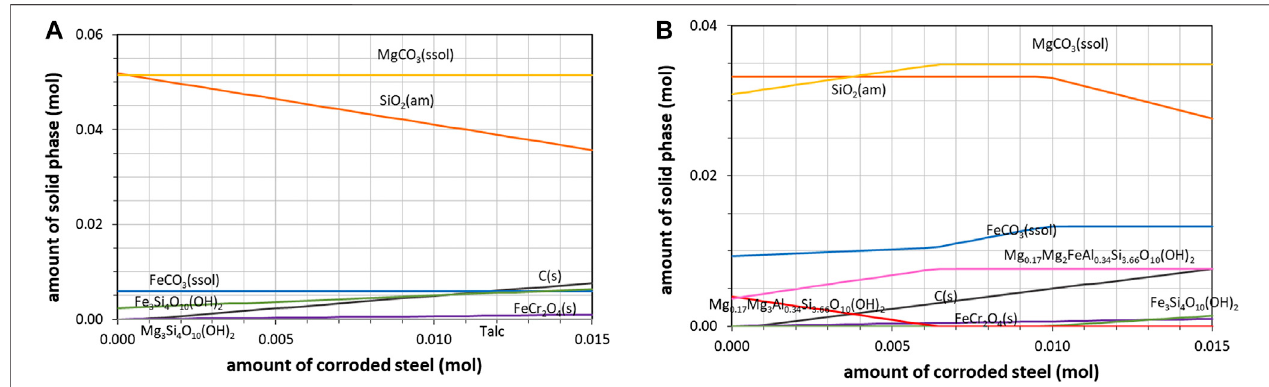
Frontiers in Chemical Engineering |